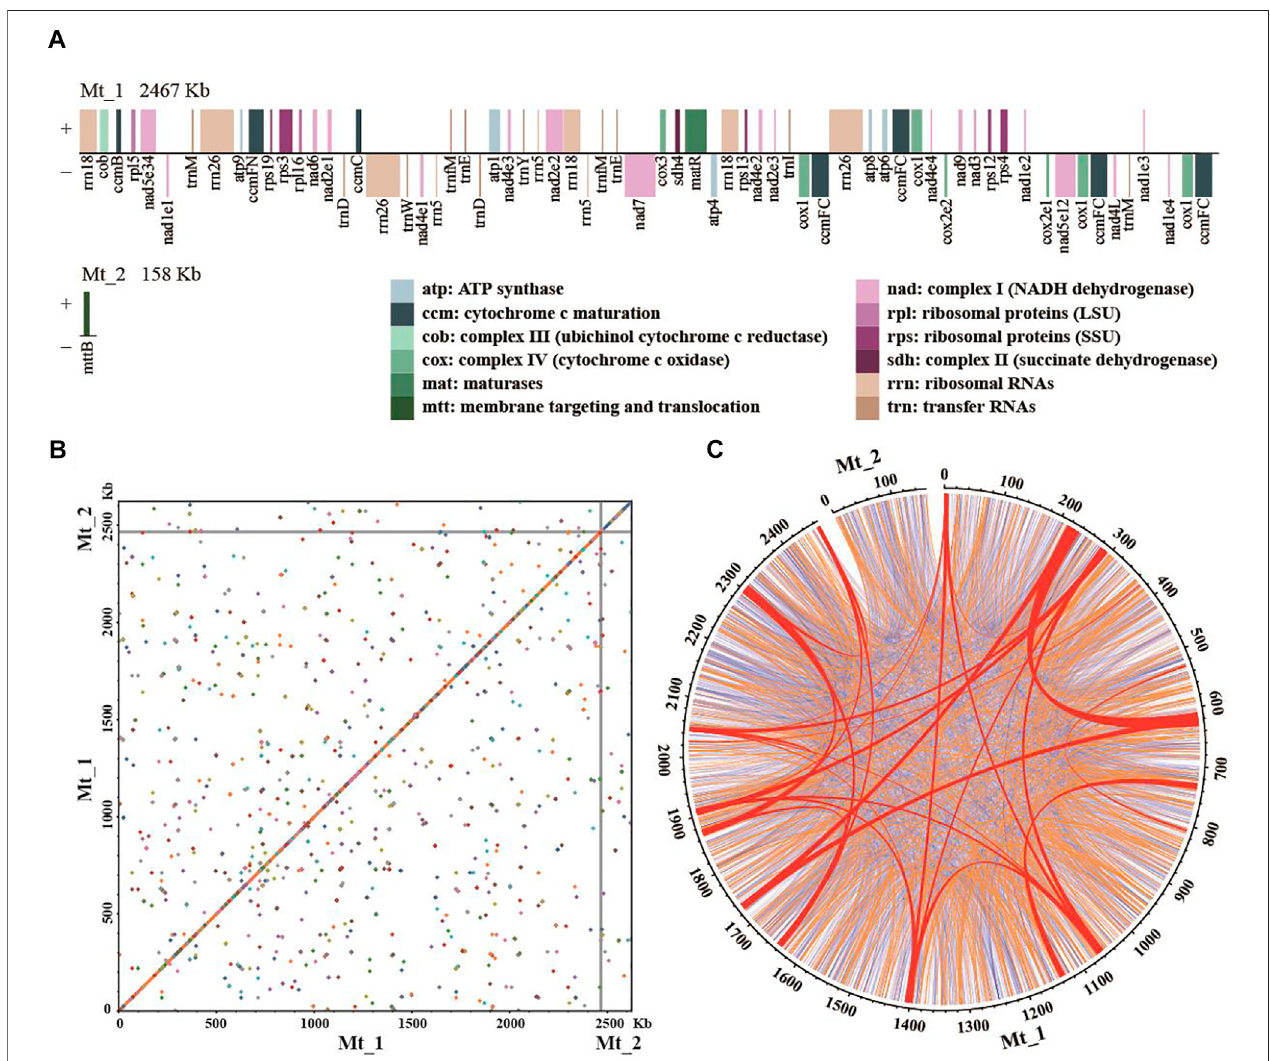
FIGURE1| Themitogenomeassemblyof Platycladusorientalis. (A) Theorder,orientation,andsizeofgenesonthetwochromosomesof P.orientalis mitogenome. The nad1 , nad2 , nad4 , nad5 , and cox2 are trans -splicing genes. Each box is proportional to the size of the gene including introns; genes with < 200 nucleotides are shown as 200nucleotides. Intergenic regions are not toscale. (B) The dot plot shows self-alignment. Dots represent the homology sequences with length > 100 bp. (C) Distributionofdispersedrepeats.Large-sizerepeats ≥ 1,000 bpinlengthareindicatedinred,medium-sizerepeatsintherangeof100 – 1,000 bpareinorange,and small-size repeats < 100 bp are in blue. The numbers on the ring anchor genome coordinates in